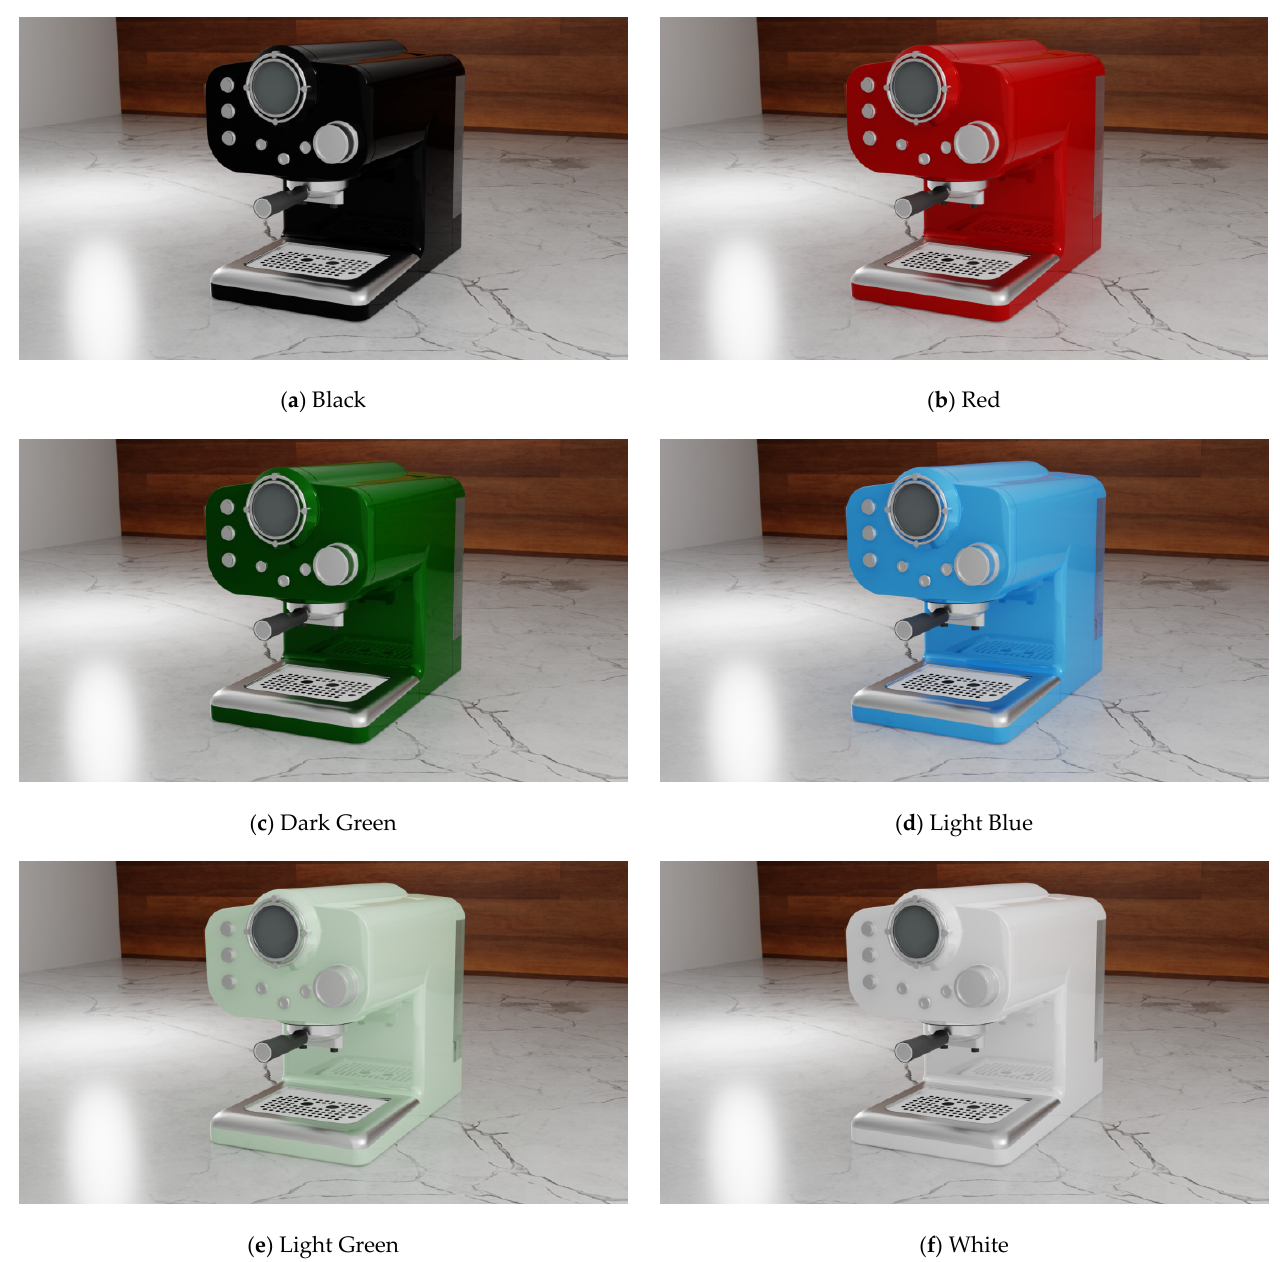
Figure 1. Visual stimuli of the 6 color settings of the coffee maker (top to bottom: ( a ) black, ( b ) red, ( c ) dark green, ( d ) light blue, ( e ) light green, ( f ) white). (For specific interpretations of the colors in this figure, the reader is referred to Table 1).